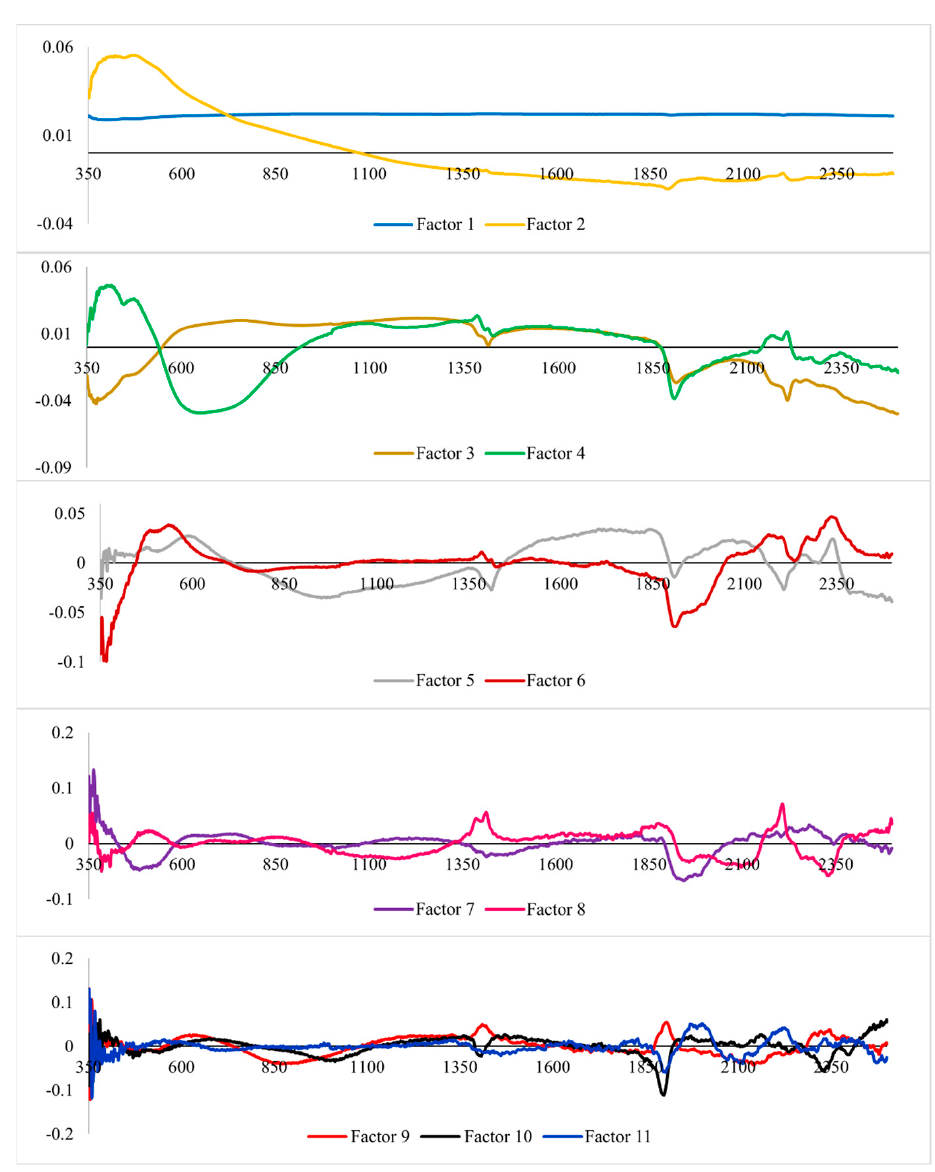
Figure 10. PCR model loadings for A1 using smoothed reflectance to estimate SOC.